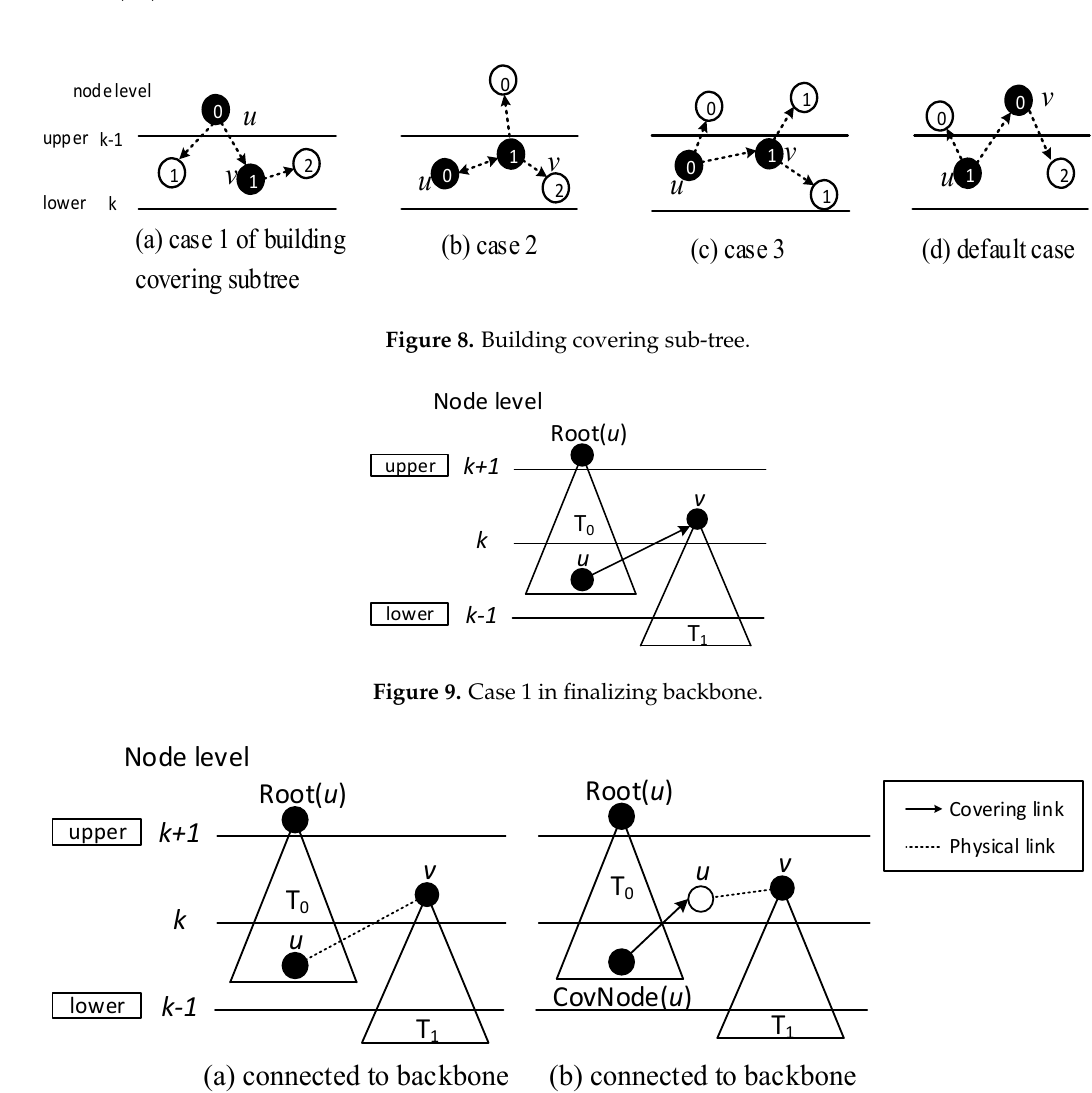
Figure 10. Case 2 in finalizing backbone.